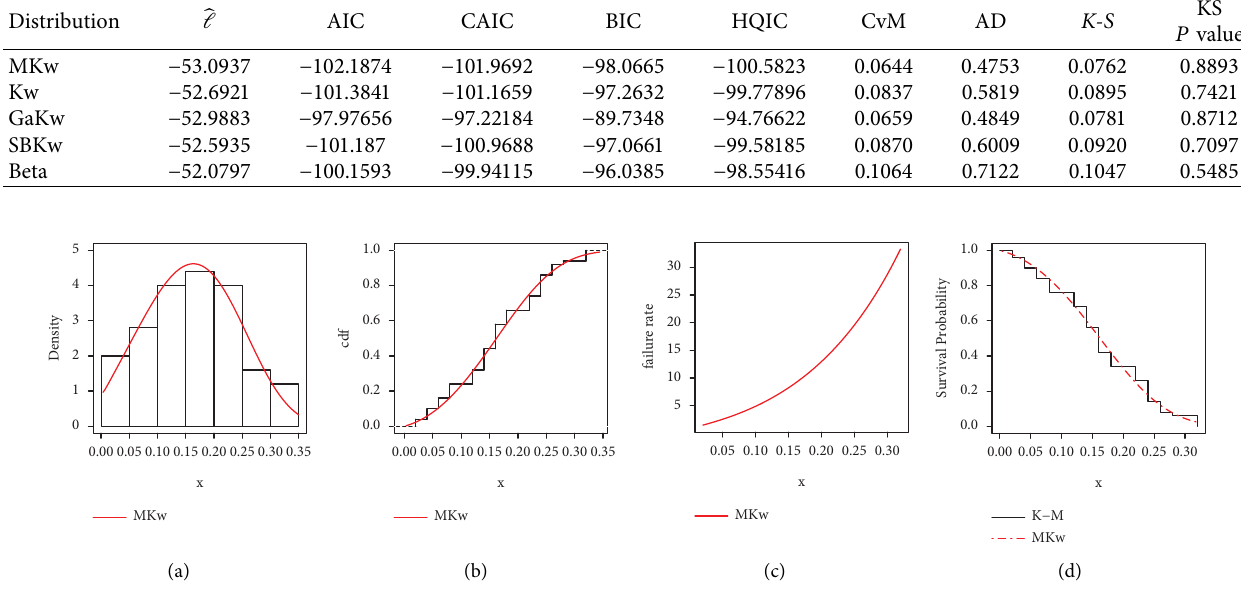
Figure 7: Plots of estimated pdf, estimated cdf, estimated hrf, and failure rate for data set 1.